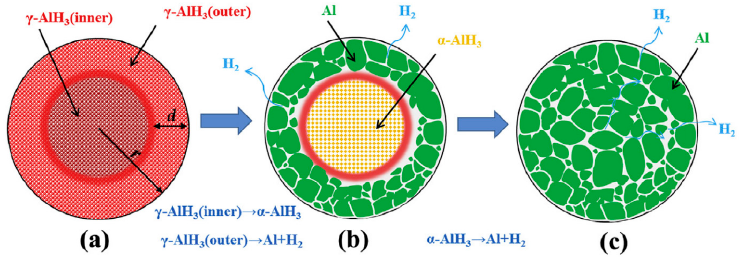
Figure 9. Schematic picture showing the outer layers and the inner parts of γ − AlH 3 particle behaving with different decomposition mechanisms: ( a ) as-synthesized γ − AlH 3 , ( b ) after partial decomposition, ( c ) after full decomposition. Reprinted with permission from Ref. [62]. Copyright 2017 Elsevier.